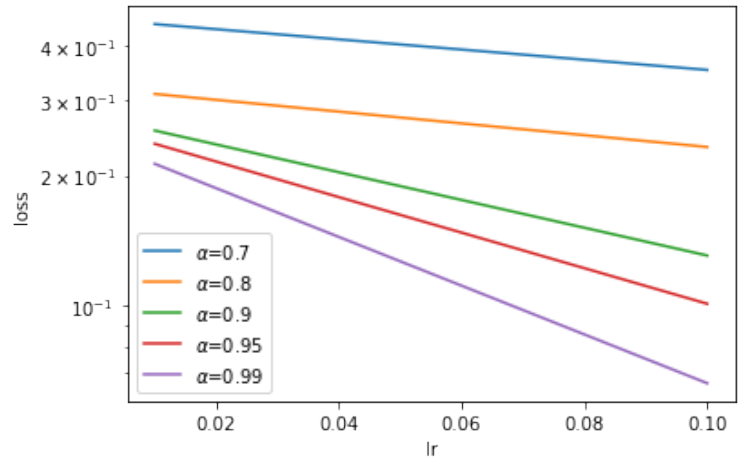
Figure 1. Effects of fractional order parameter α , where lr = η denotes the learning